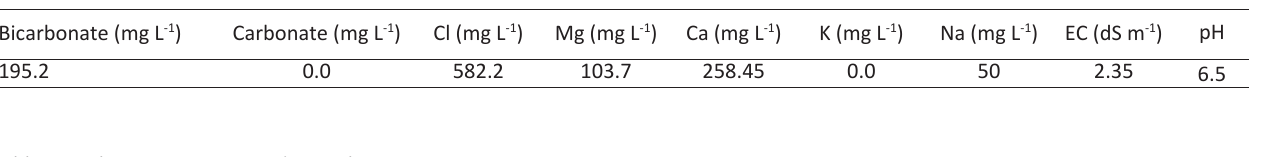
Table 3 - Climatic parameters during the growing seasons Climatic parameters